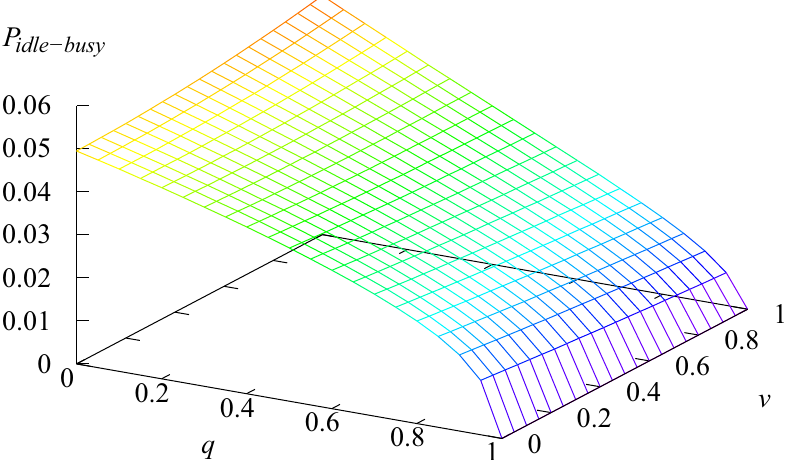
Figure 11. Dependence of the probability P idle − busy that the main server is idle while the secondary server is busy on the parameters q and ν .